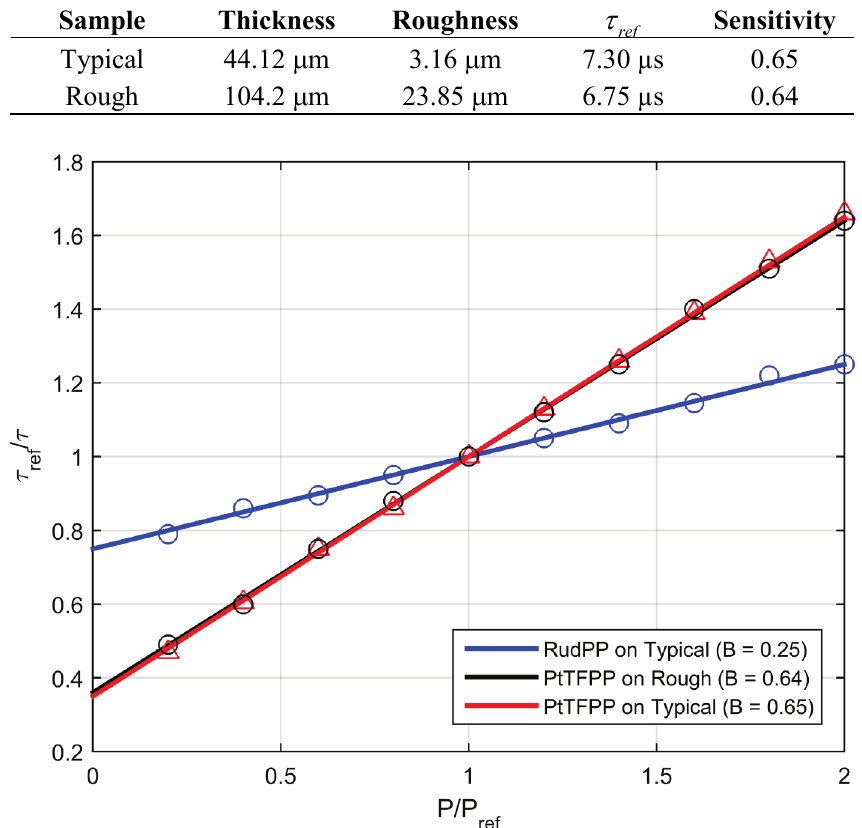
Table 1. PtTFPP sample characteristics.